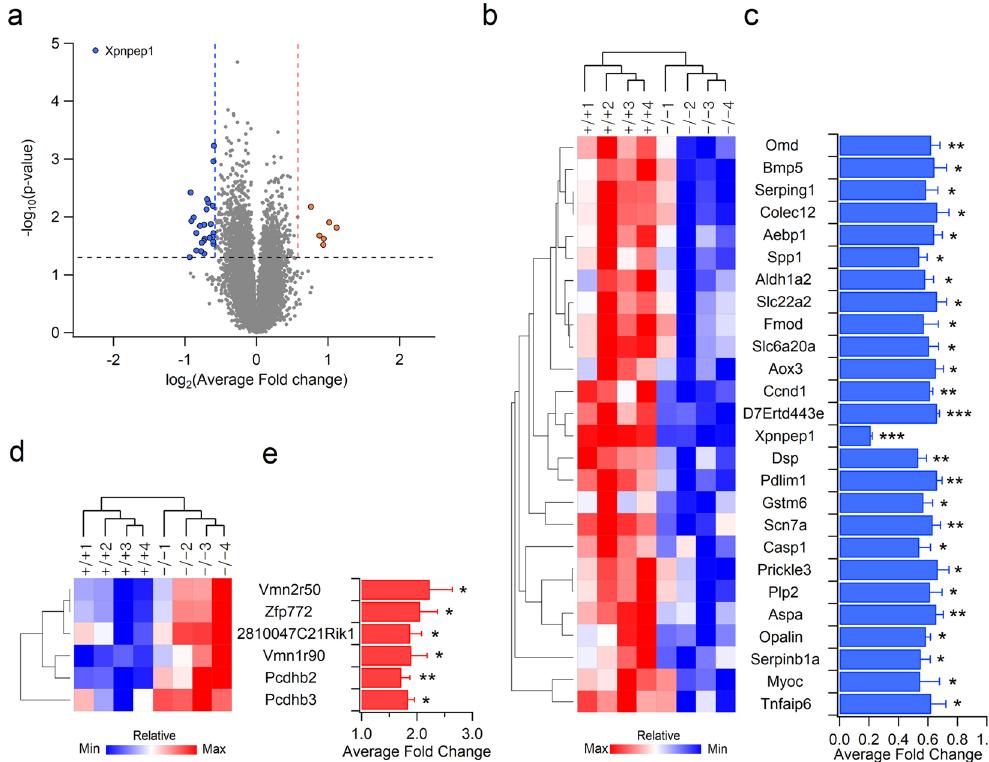
Figure 1. Microarray analysis of gene expression profiling in the Xpnpep1 −/− hippocampus. ( a ) Volcano plot showing the fold change and p value of the individual probe sets by microarray analysis. The vertical lines indicate 1.5-fold up-regulation (dotted red line) and down-regulation (dotted blue line), respectively. The horizontal dotted line represents the cutoff significance level ( p = 0.05). The red and blue dots indicate up-regulated and down-regulated genes, respectively, with statistical significance. ( b ) The down-regulated genes in the Xpnpep1 −/− hippocampus are visualized by heatmap and hierarchical clustering. Each gene and sample were clustered by similarity between the expression patterns of genes. Red indicates high relative expression and blue indicates low relative expression. ( c ) Bar graphs represent average fold changes of down- regulated genes in the Xpnpep1 −/− hippocampus. ( d , e ) Treeview and hierarchical clustering ( d ) and average fold changes ( e ) of up-regulated genes in the Xpnpep1 −/− hippocampus. ( b , d ) Male: +/+1, +/+4, −/− 1, and −/−4; female: +/+2, +/+3, −/−2, and −/−3. ( c , e ) * p < 0.05; ** p < 0.01; *** p < 0.001 by Student’s t -test, n = 4